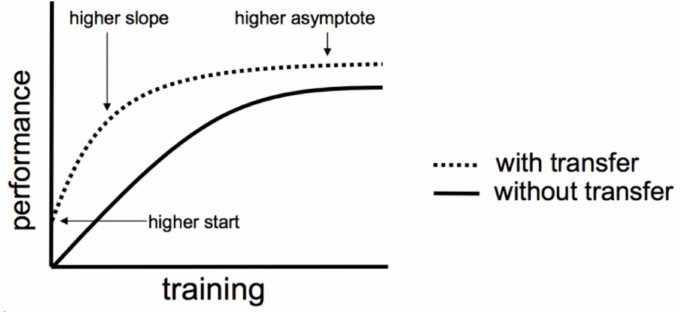
Figure 4. The effect of transfer learning on model